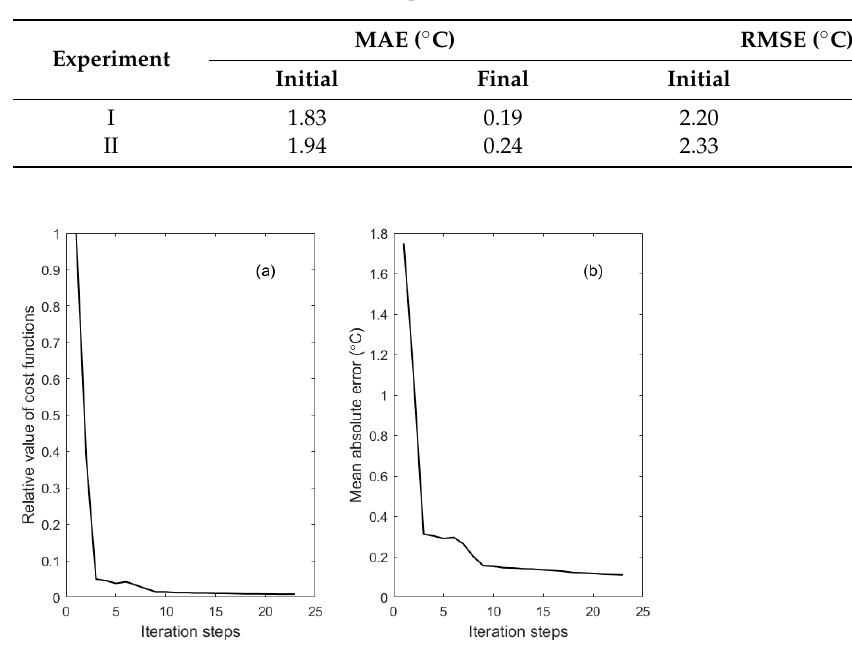
Figure 6. Cost function (a) and MAE (b) change related to the iteration steps in ideal experiment I.